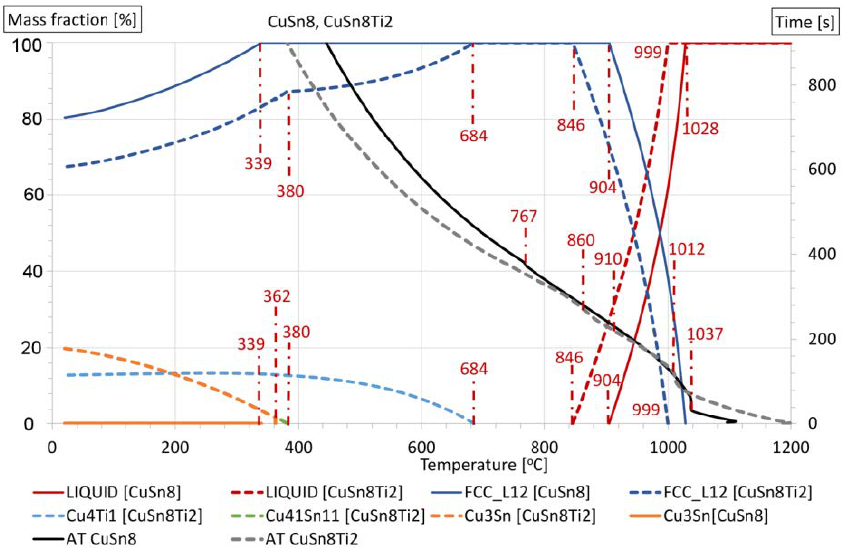
Figure 1. Crystallisation pathways of selected alloys: CuSn8 and CuSn8Ti2, on the bases of experi- mental data and thermodynamic modelling by the CALPHAD method and AT.